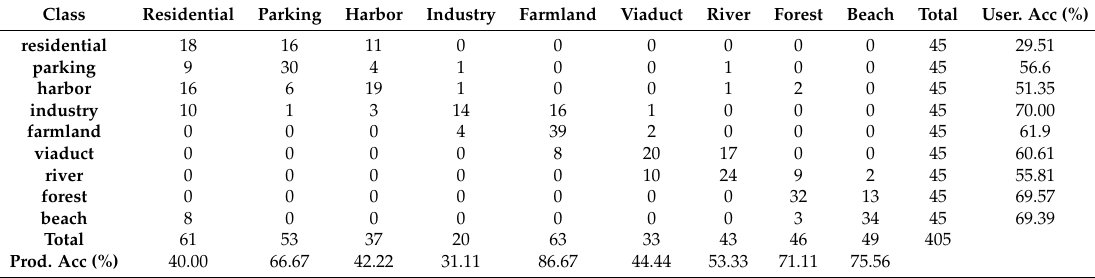
Table 5. The confusion matrices of Multi-Fuse based SMRMKL with 10 target positive examples per class for aerial-to-satellite classification. The overall accuracy is 56.79% and the Kappa is 0.5139.